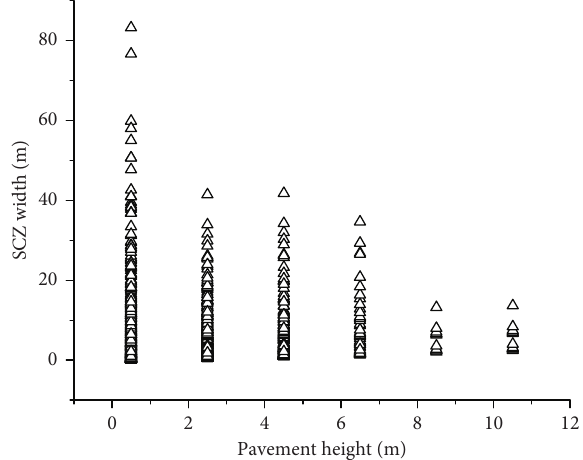
Figure 12: Relationship between l and the pavement